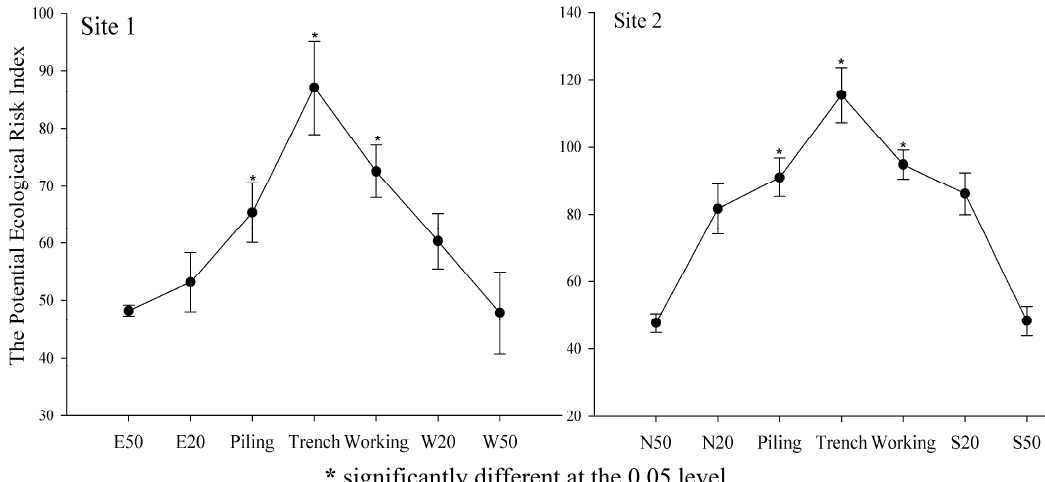
* significantly different at the 0.05